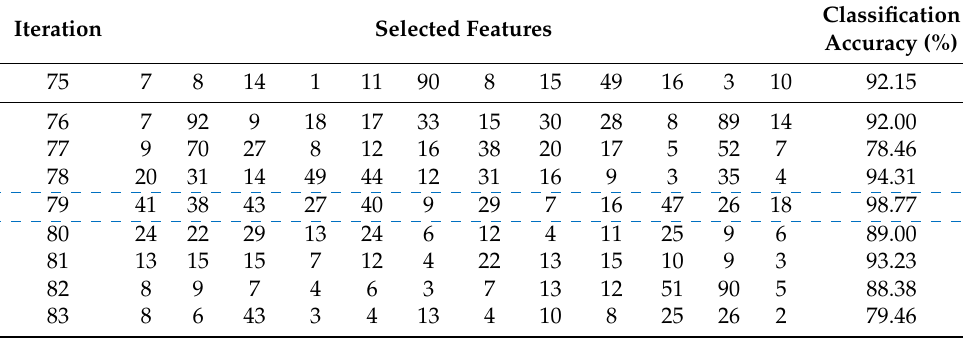
Table 5. Classification accuracy of each iteration having different selected features. Iteration